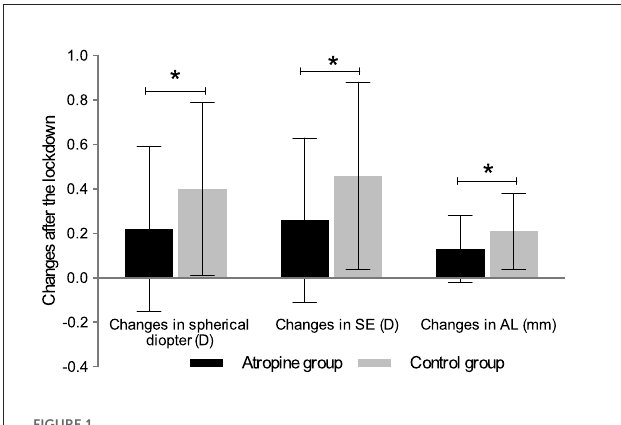
FIGURE1 Changes of spherical diopter, SE and AL in atropine and control group after the 2022-lockdown in Shanghai. *Significant difference between the two groups. SE, spherical equivalent; AL, axial